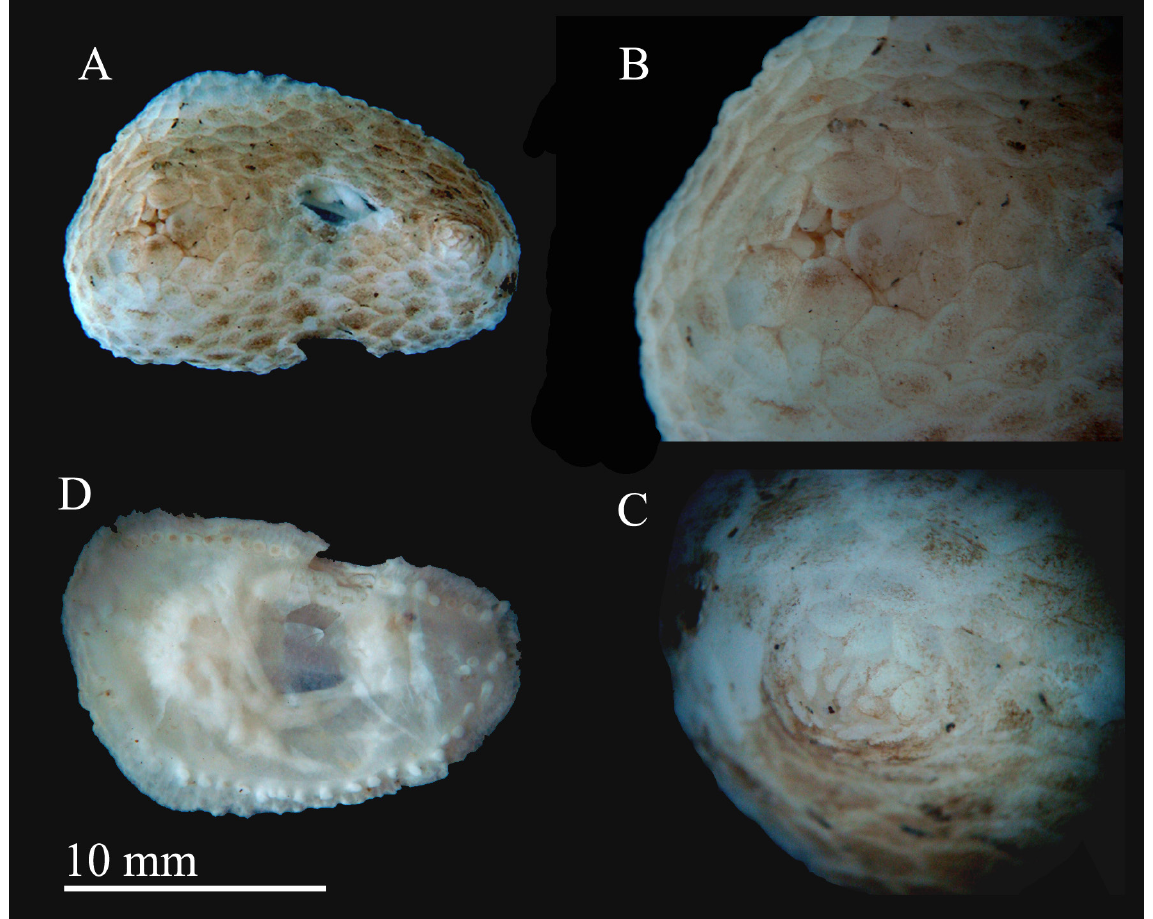
Fig. 1. Psolus tessellatus Koehler, 1896. A . Dorsal view. B . Buccal cone. C . Anal cone. D . Ventral